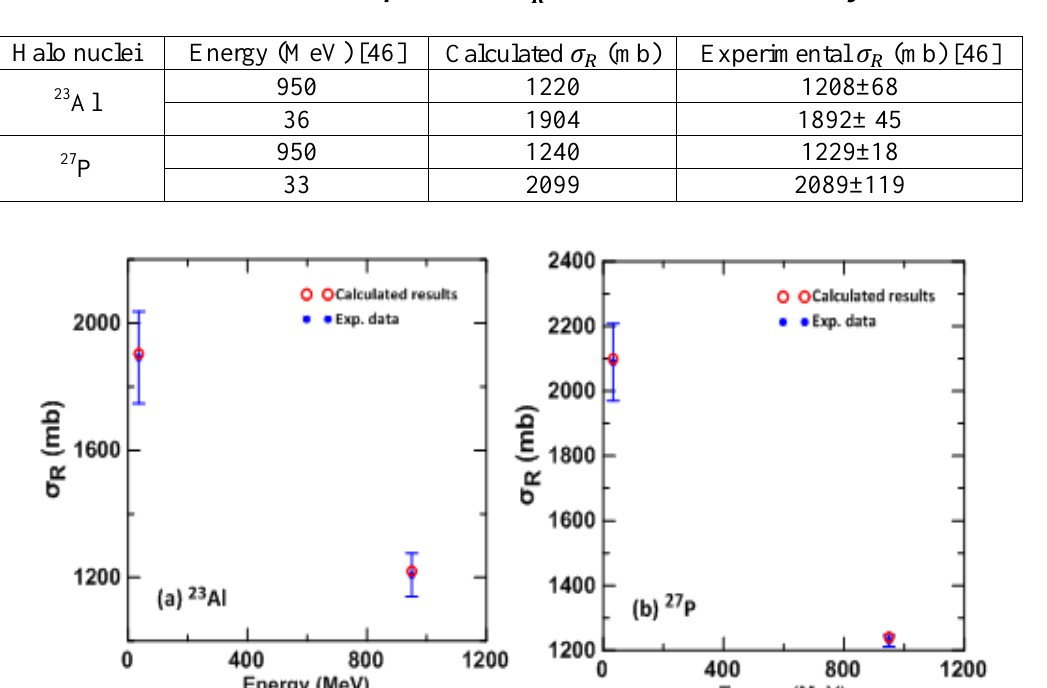
Table 3: Calculated and experimental